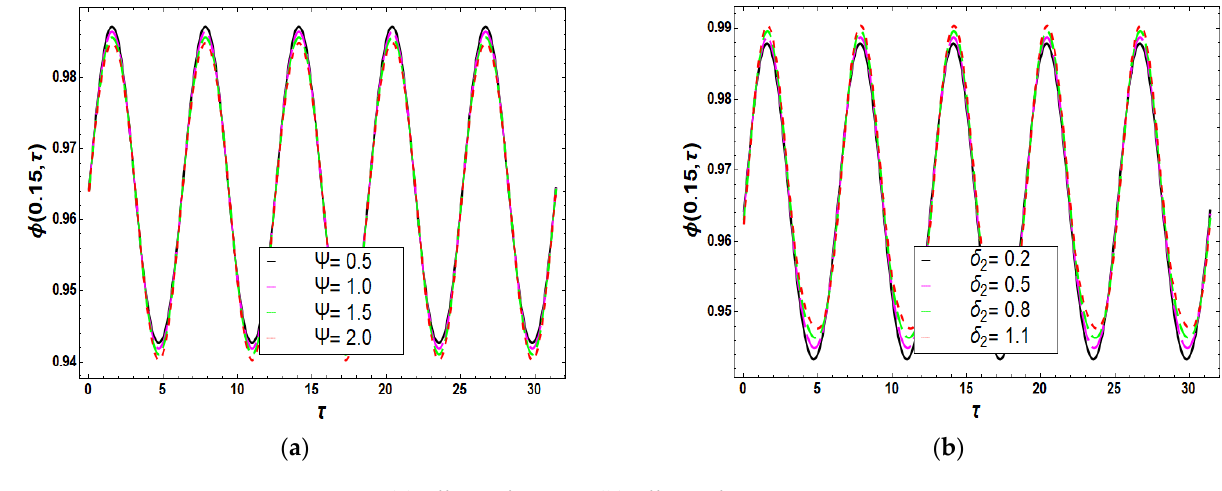
Figure 7. ( a ) Effects of Ψ on φ . ( b ) Effects of δ 2 on φ . Figure 7. ( a ) E ff ects of Figure 7. ( a ) E ff ects of